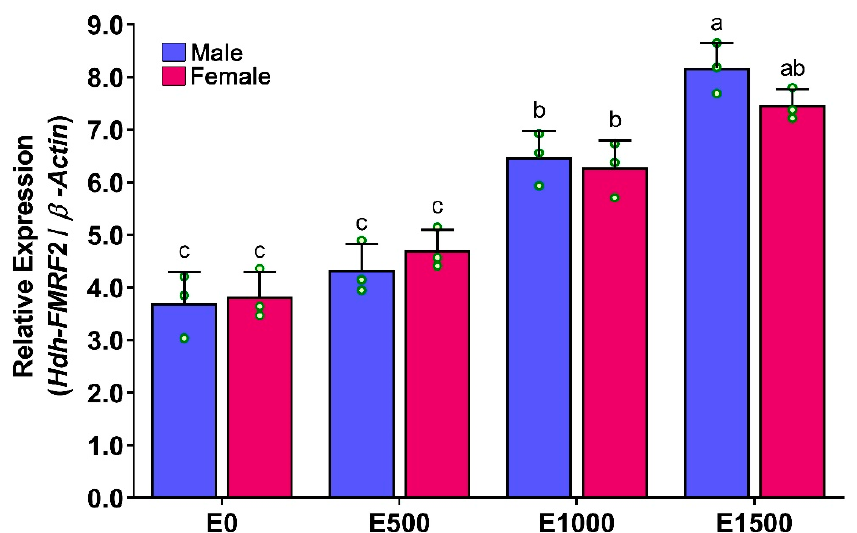
Figure 9. Changes in mRNA expression levels of Hdh-FMRF2 in the cerebral ganglion of different EAT °C-days of Pacific abalone in both sexes exposed to EAT during broodstock conditioning. For all bar graphs, the raw data points (green circle) represent biological replicates, the error bars represent the standard error of the mean (SEM), and different letters above the bars indicate significant differences ( p < 0.05) among EAT °C-days. EAT 00, EAT 0°C-days; EAT 500, EAT 500°C-days; EAT 1000, EAT 1000°C-days; EAT 1500, EAT 1500°C-days.